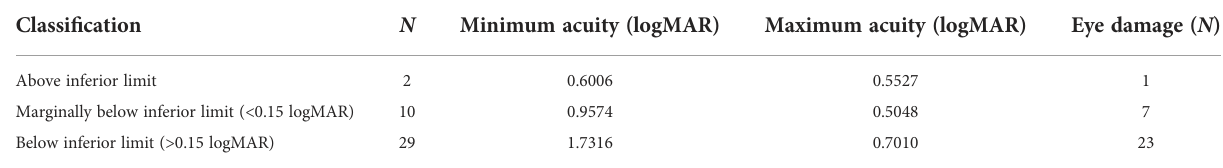
TABLE 1 Visual acuity (VA) by classi fi